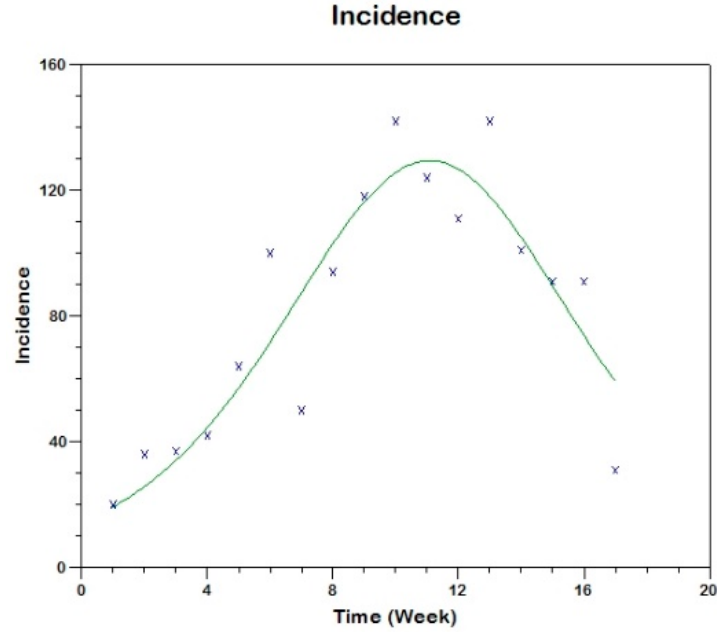
Figure 13. Model fit to the cumulative reported incidence of the second outbreak in Tolima-Colombia using Method 0.